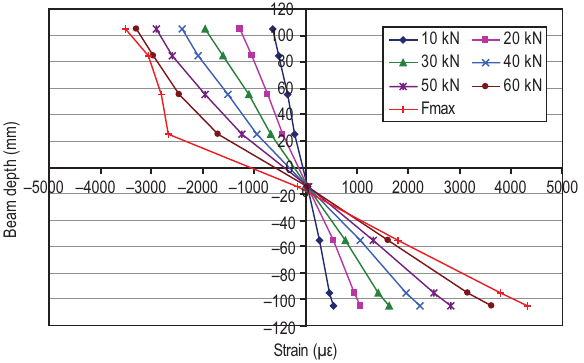
Fig. 10. Strain profile at different load levels for beams reinforced with two CFRP plates (Beam